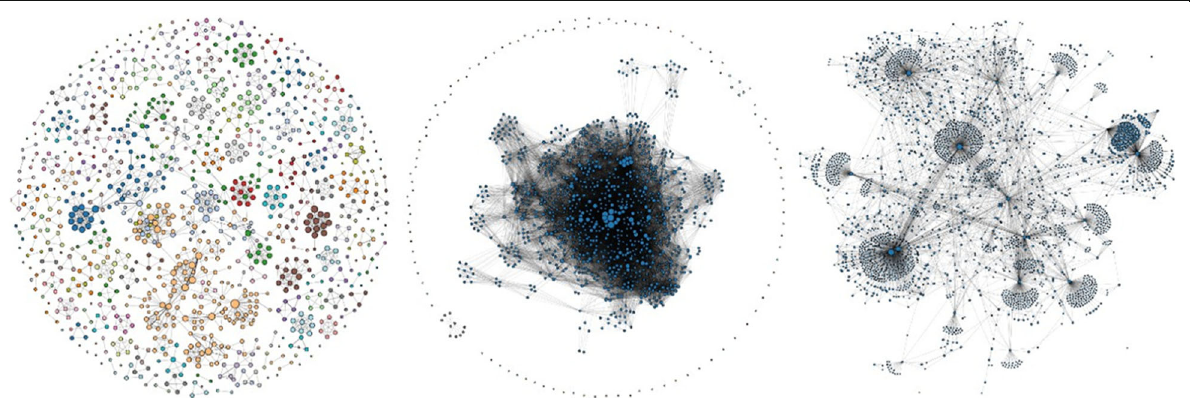
Fig. 1 Node-link diagrams of real-world datasets: co-authorships, co-citations, and a Comprehensible Perl Archive Network (CPAN) distribution (cpa 2019)